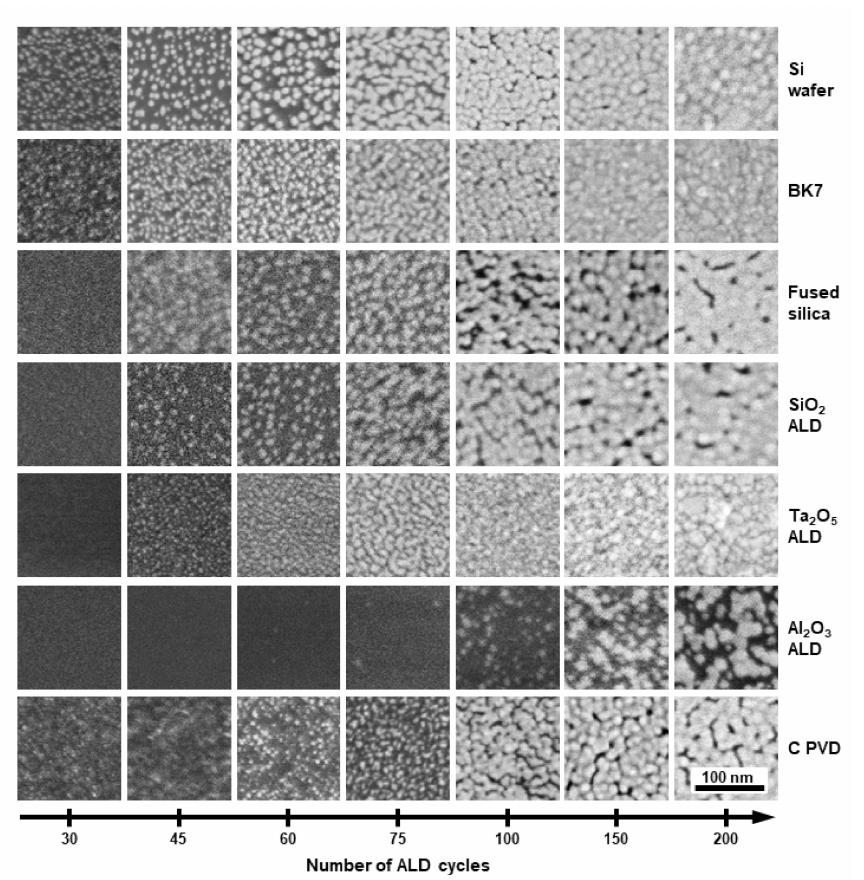
Figure 1. Scanning electron microscope (SEM) images (top-view) of iridium (Ir) coatings depending on the number of ALD cycles (columns) on Si wafers, BK7, and fused silica as well as seed layers of SiO 2 , Ta 2 O 5 , Al 2 O 3 , and C (rows). Iridium appears bright on the dark substrate materials. The scale bar in the bottom right corner is valid for all